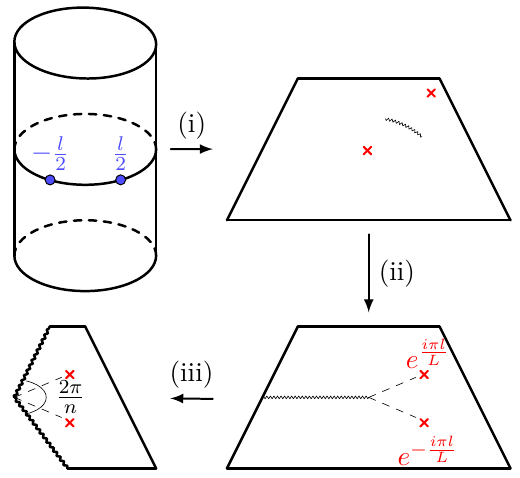
Figure 1 . Pictorial representation of the geometric setting for the SRD. (i) The reduced density matrix is represented by the sheet with respective operator insertions (red crosses) at 0 and ∞ . (ii) A Möbius transformation maps the insertion points to e ± iπl L and the branch cut to the negative real line. (iii) The multiplication by negative fractional powers of the reduced vacuum states is given cutting out respective parts of the